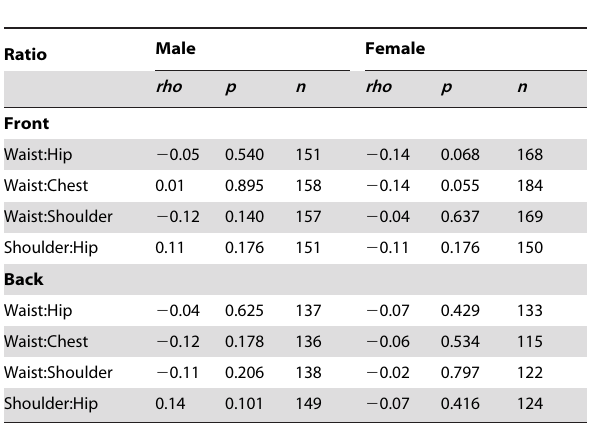
Table 1 . Results of Spearman correlation analyses of the percentage of exposed naked skin and sexually dimorphic body